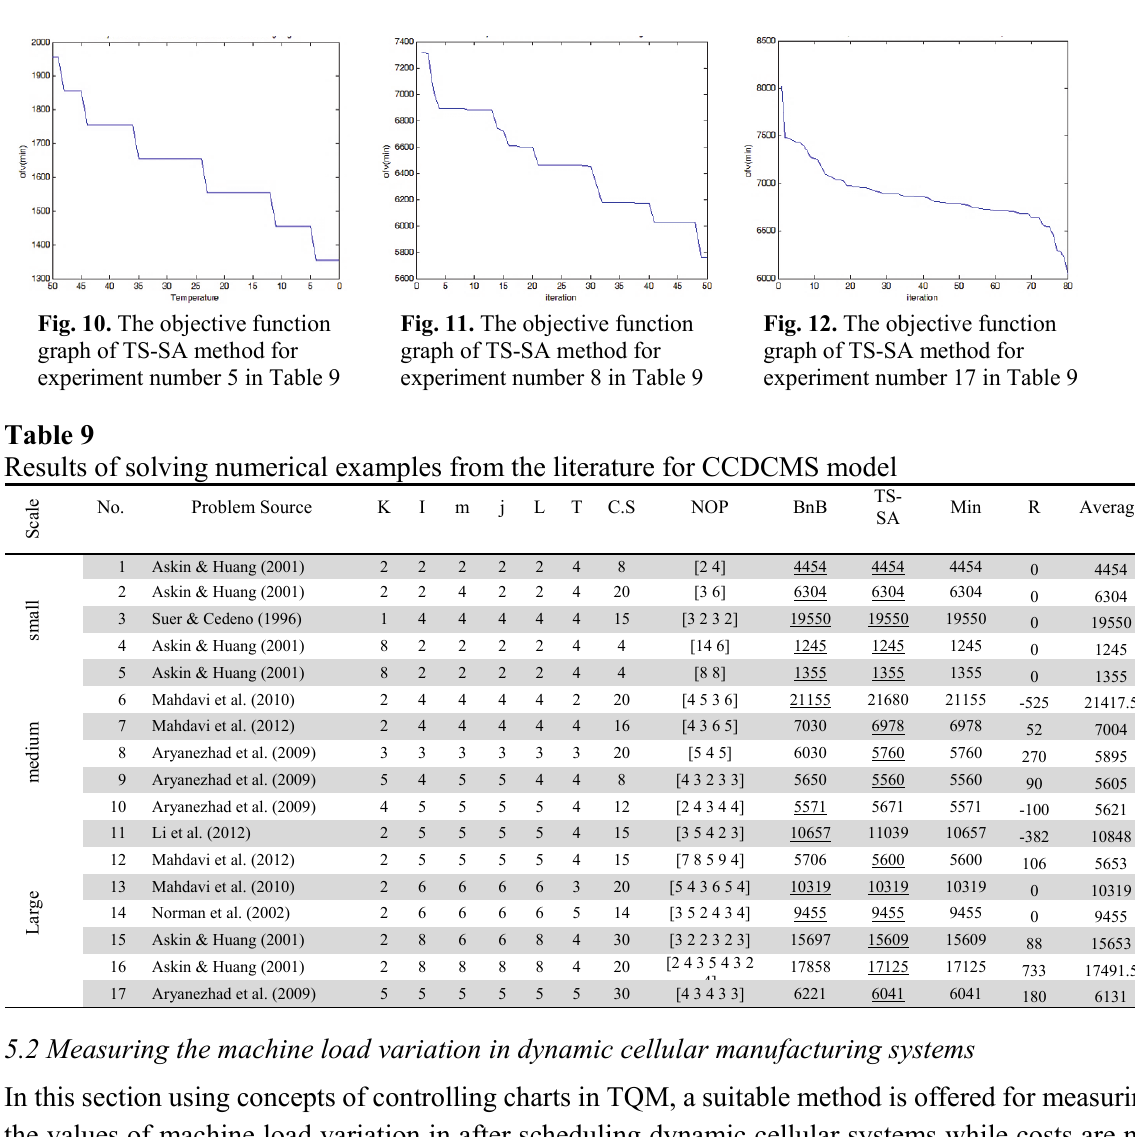
Fig. 10. The objective function graph of TS-SA method for experiment number 5 in Table 9